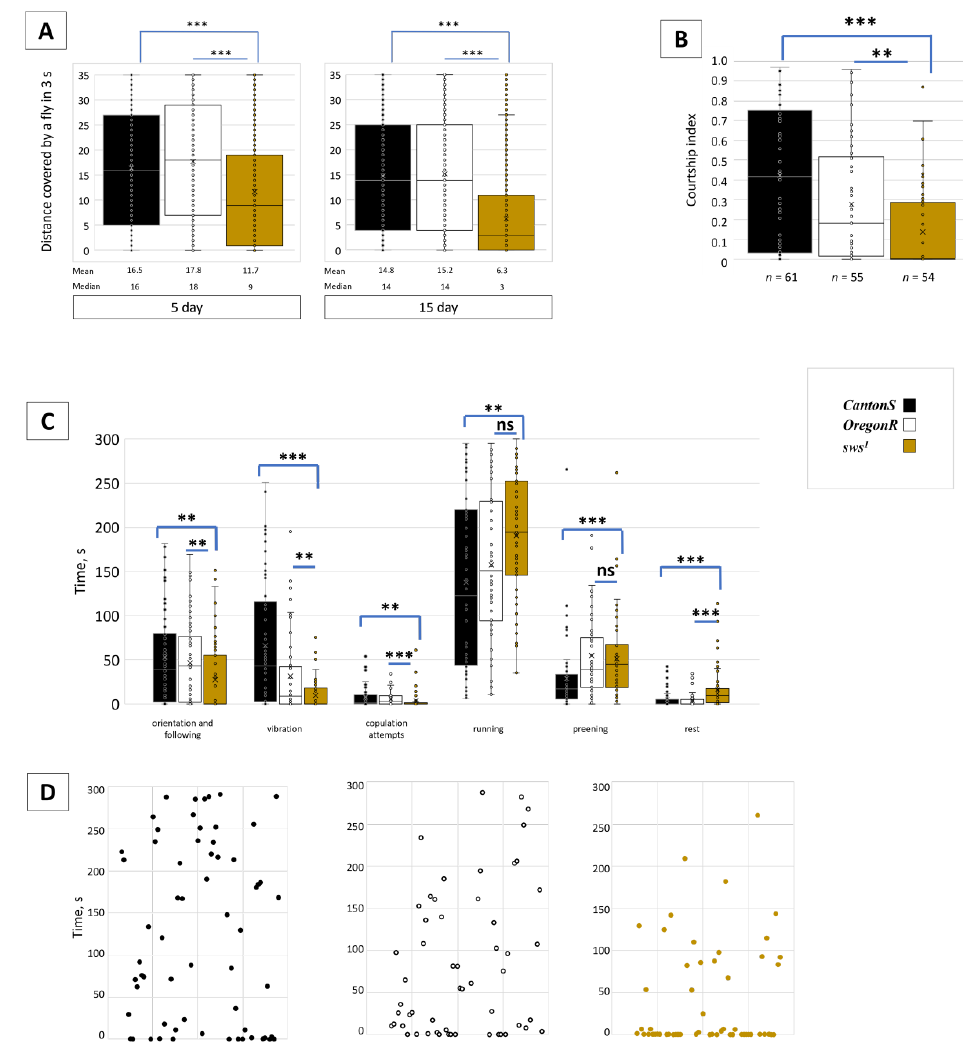
Figure 6. Behavioural analysis. ( A ) Locomotor activity of 5 and 15-day-old males; n = 2000. ( B ) Courtship index (the ratio of courtship time to the total time of behaviour examination) of 5-day-old males; the sample size is written under each bar. ( C ) Time spent for different types of male behaviour, of the total registration period of 300 s (when 4–6-day-old males were coupled with a mated CantonS female); the sample size is equal to (B). ( A – C ) Steel test; ** p < 0.01; *** p < 0.001; ns—no significant difference ( p > 0.05). ( D ) Total time of sex behaviour (orientation, following, vibration, copulation) of individual males among the total 300 s registration time. Note that most of the sws 1 mutant males spend less time for courtship than the wild type CantonS and OregonR